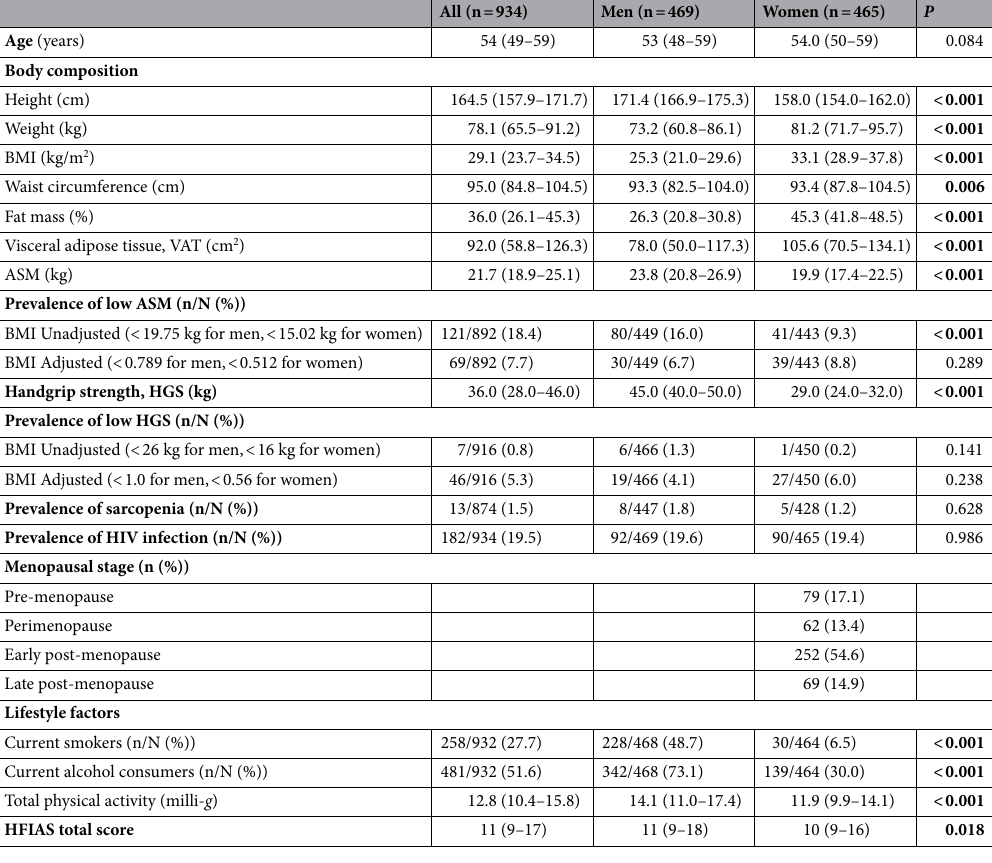
Table 1. Characteristics of the study sample. Continuous variables are presented as median (Interquartile Range), and categorical data are presented as observations/total non-missing observations (n/N (%)). A Wilcoxon rank-sum test was used to compare the continuous variables statistically, while a chi-square test was used to compare the categorical variables. P values < 0.05 are indicated in bold. n: Number of observations; P: